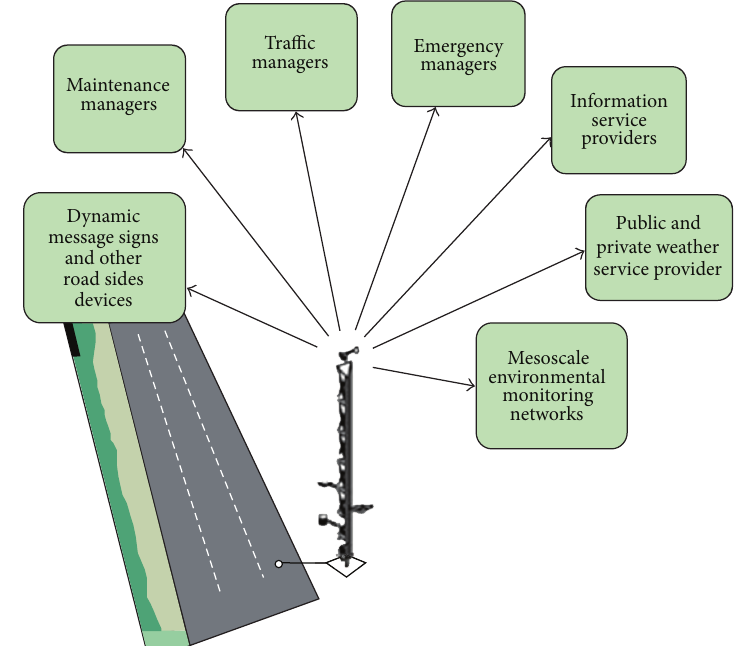
Figure 2: Operational application of environmental sensor